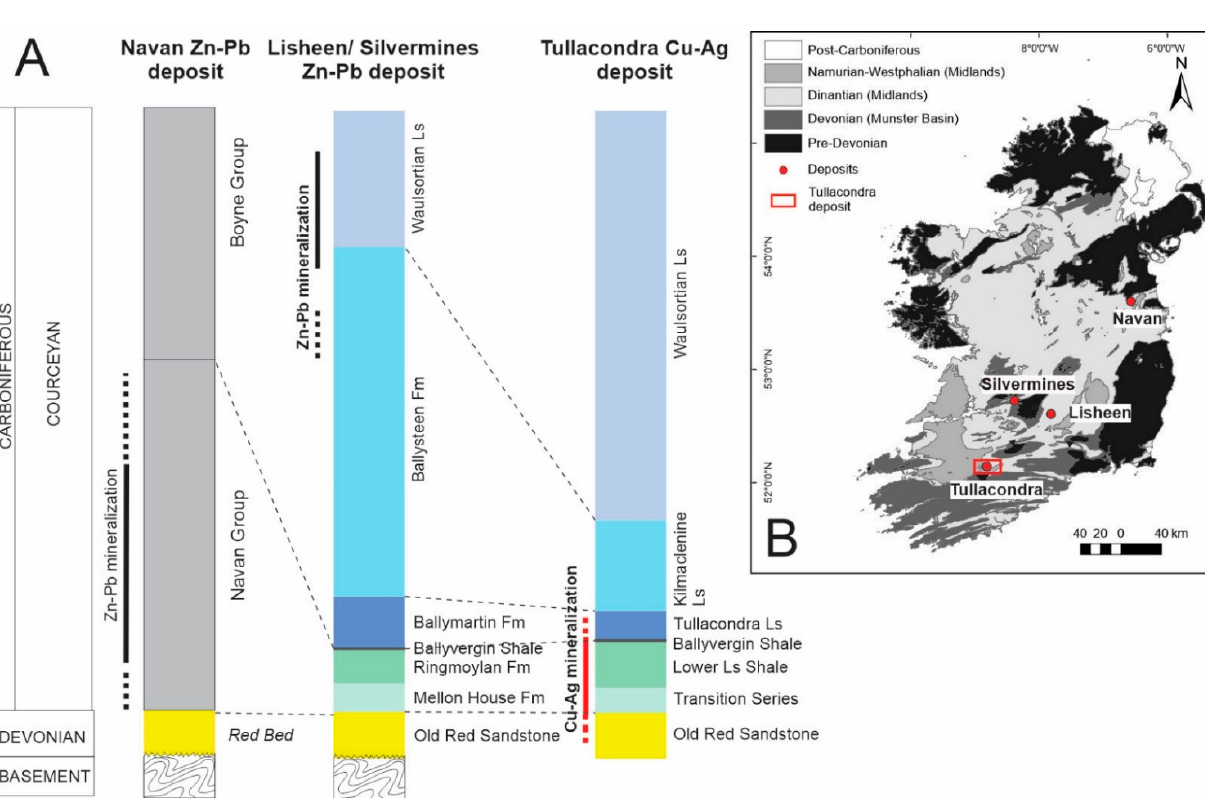
Figure 1. ( A ) Stratigraphic columns for the Navan, Lisheen, Silvermines, and Tullacondra deposits showing the lateral stratigraphic variation and the main host lithologies. The Waulsortian Limestone hosts the Lisheen and Silvermines deposits, the Navan Group hosts the Navan deposit, and the L.L.S hosts the Tullacondra deposit. Note also that the L.L.S. is laterally correlated with the Navan group. The Navan deposit column is based on [4,47–49]. The stratigraphic column for the Lisheen and Silvermines deposits is based on [2,3,13,36,47,49], and for the Tullacondra deposit on [6,10]. ( B ) Geological map of Ireland showing the main stratigraphic units and deposits. Note the localization of the Tullacondra in southern Ireland. Navan, Lisheen, and Silvermines are important sources of Zn-Pb. This map is based on data available by G.S.I. (see in Data Availability Statement).